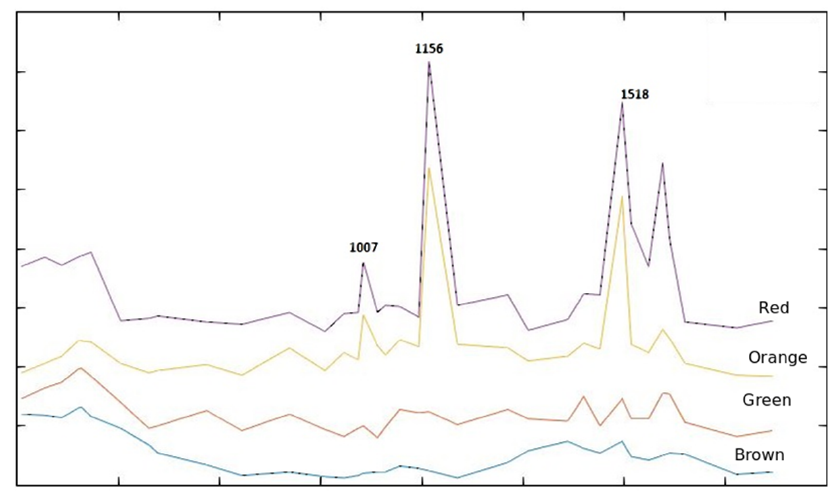
Figure 9. Spectra of tomato maturity behavior using Raman spectroscopy [84].